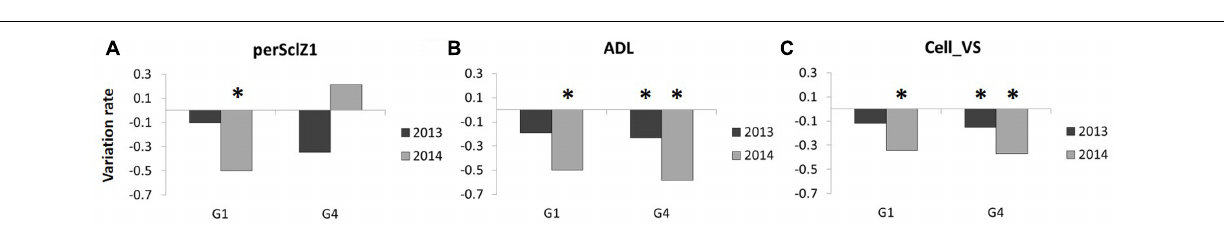
FIGURE 6 | Variation of (A) perSclZ1, (B) ADL, (C) Cell_VS (perSclZ1: percentage of sclerenchyma tissue (red stained) in % of Z1 area, ADL: Acid Detergent Lignin in %DW, Cell_VS: cellulose content in %DW) between water deficit (WD) and well-watered (WW) treatments, measured at the end of the WD period on the internode of rank 2 below the last ligulated leaf phytomer; for 2 genotypes (G1: Biomass140 and G4: RE1xAR4) and 2 years (2013 and 2014); variation rate is computed as [(WD value) – (WW value)]/(WW value) using data averaged on the three blocks. ∗ Indicates a significant water treatment effect ( p -value <